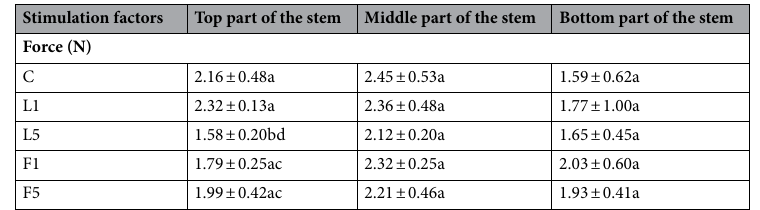
Table 2. Tensile force detaching the leaf from the petiole. C control (unstimulated seeds), L1, L5 He–Ne laser light stimulation with 1 and 5 min exposure, respectively, F1, F5 alternating magnetic field stimulation with 1 and 5 min exposure, respectively. a, b—different letters in respective columns indicate statistical differences, ± standard deviation, n = 5.